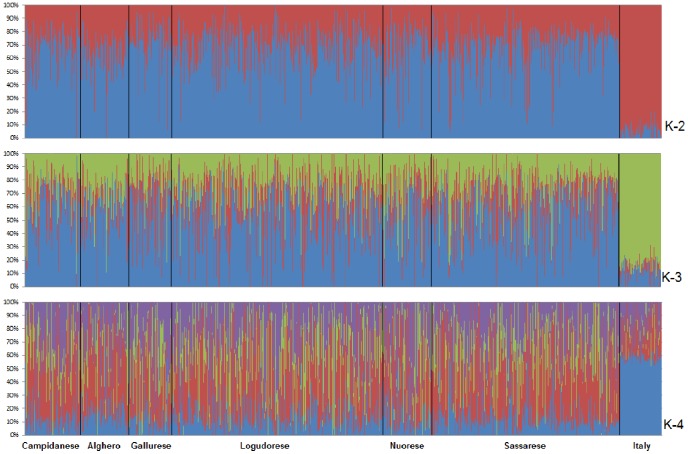
ADMIXTURE software results for K = 2–4.Ancestry for each individual inferred using ADMIXTURE software.